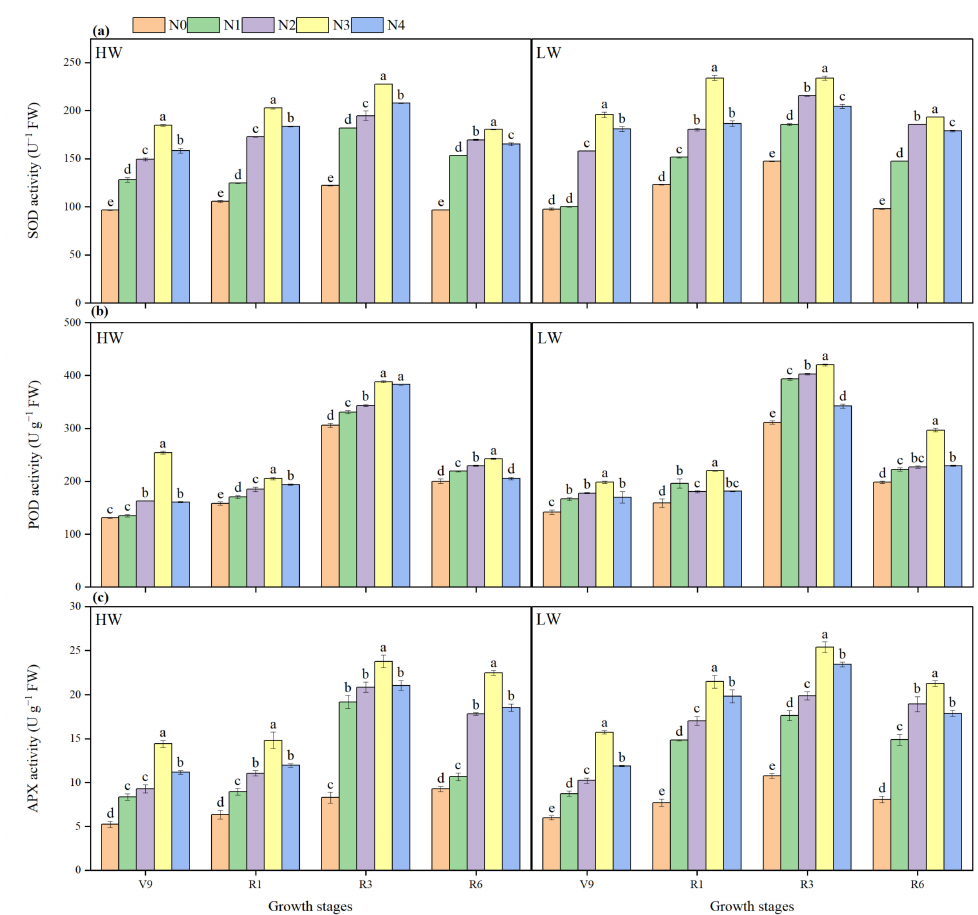
Figure 5. Effects of irrigation and nitrogen rates on SOD activity ( a ), POD activity ( b ), and APX activity ( c ). HW and LW represent irrigation water at the rate of 80 and 60% of field capacity. Means followed by different lowercase letters within each treatment indicate significant differences ( p < 0.05). Bars represents standard errors. The nitrogen treatments N0, N1, N2, N3 and N4 represent the application of nitrogen at the rates of 0, 200, 250, 300 and 350 kg ha − 1